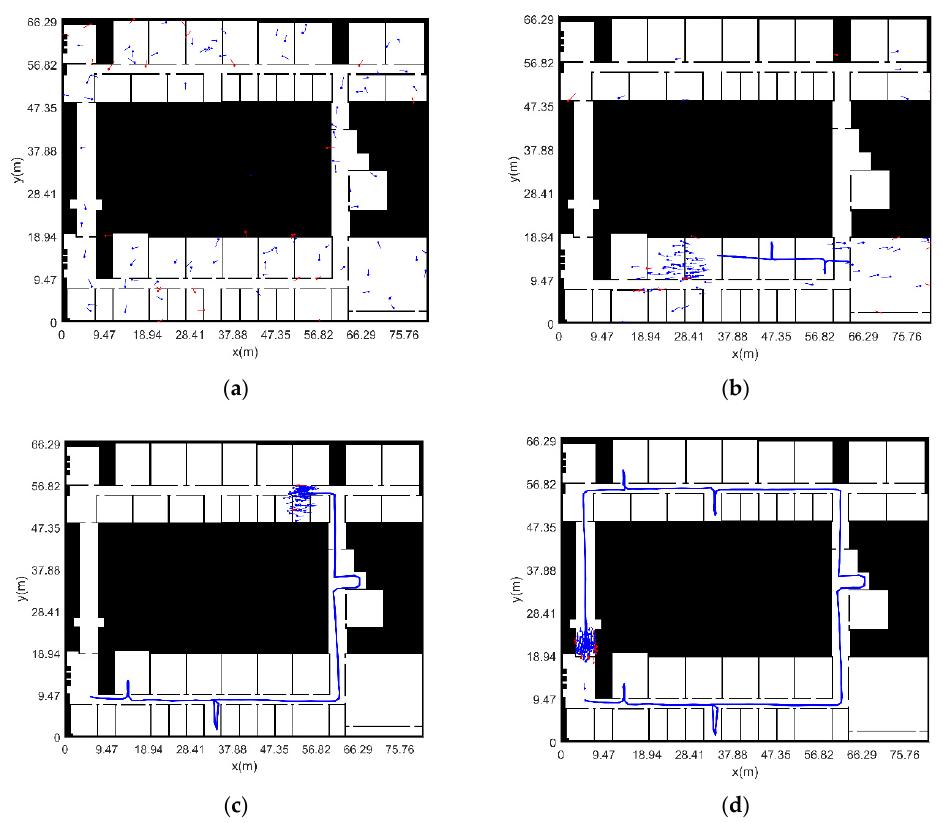
Figure 17. Distribution of sampled particles and motion trace with unknown initial position and heading. ( a ) Particle distribution at initial moment. ( b ) Particle distribution and motion track of the 58th step in the motion process. ( c ) Particle distribution and motion track of the 114th step in the